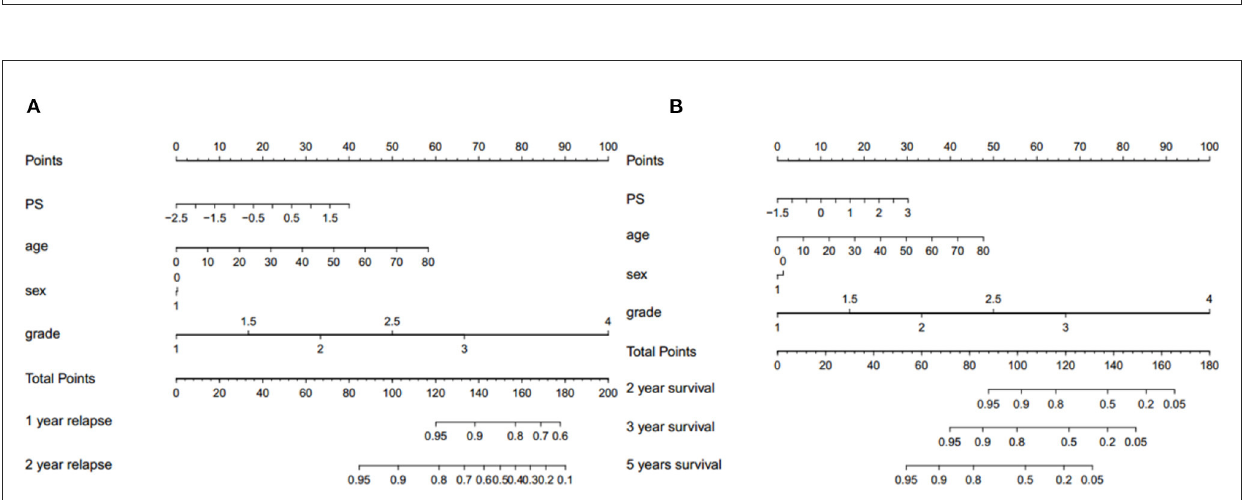
FIGURE3 The corresponding nomogram showing the contribution of different factors. “PS” refers to the pathomics signature, “Points” refers to the numerical value assigned to each predictor variable based on its current value, and “Total points” refers to the sum of the points for all predictor variables. (A) Recurrence and (B) survival.